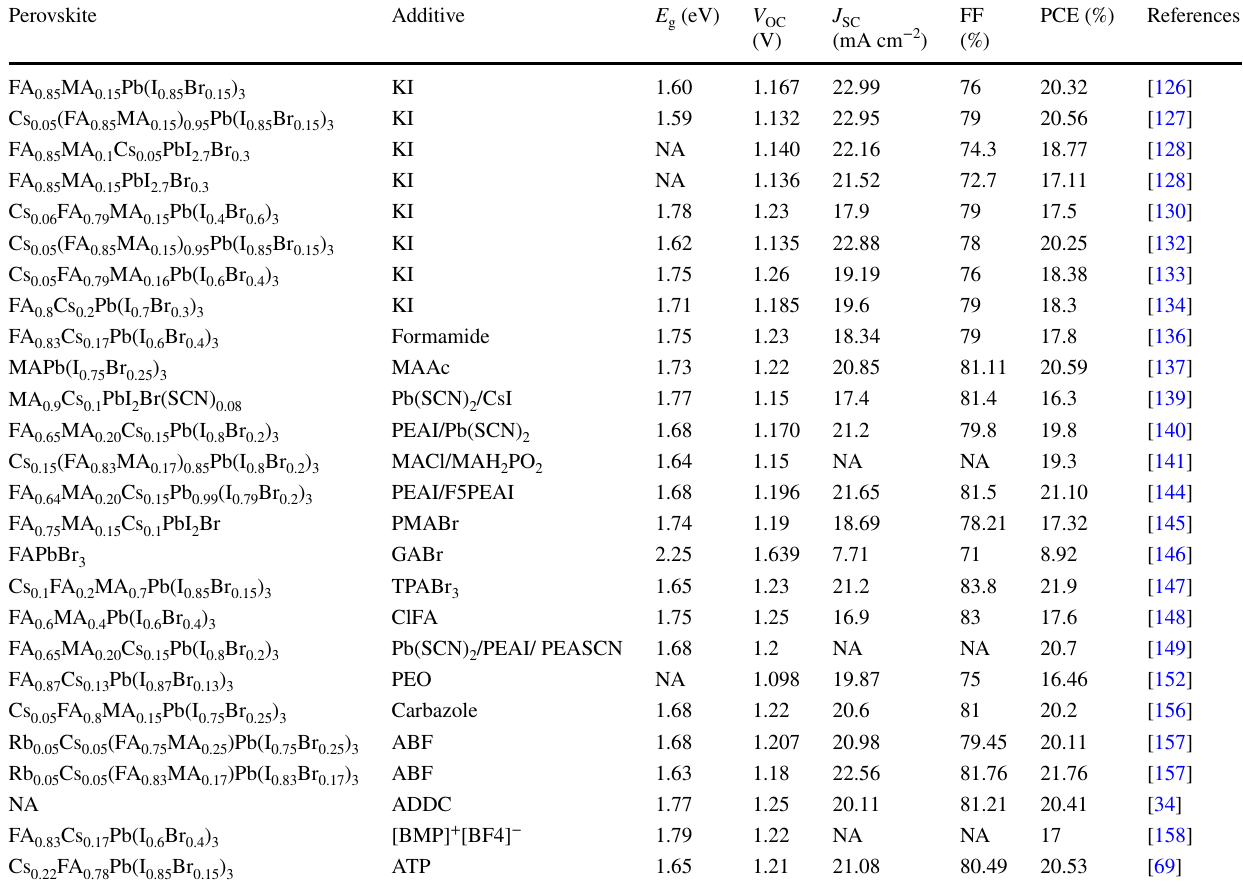
Table 3 Summary of WBG PSCs employing additive engineering Perovskite Additive E g